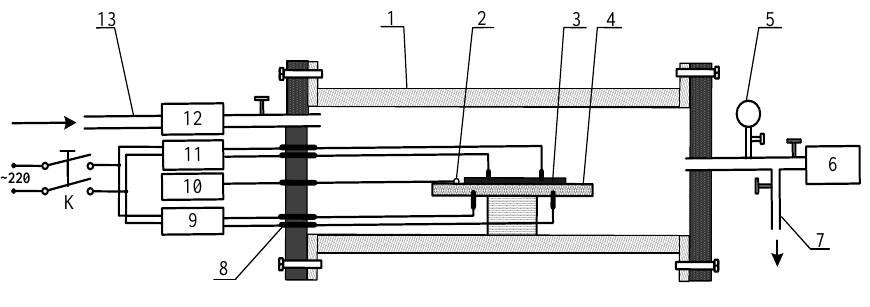
NTs sensor’s response to the SF 2